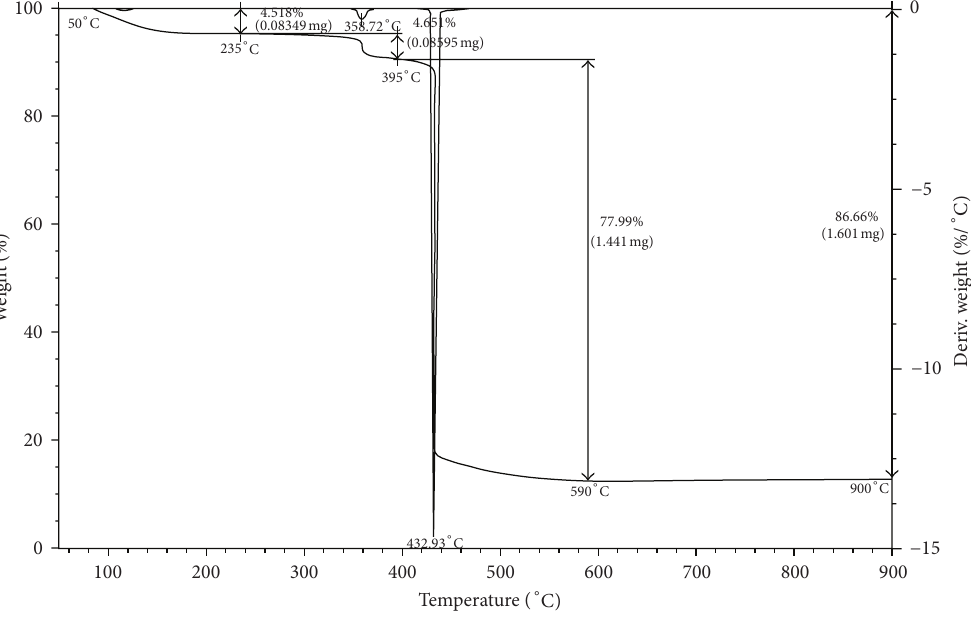
Figure 3: TGA curve of Fc-polyazomethine 6b .